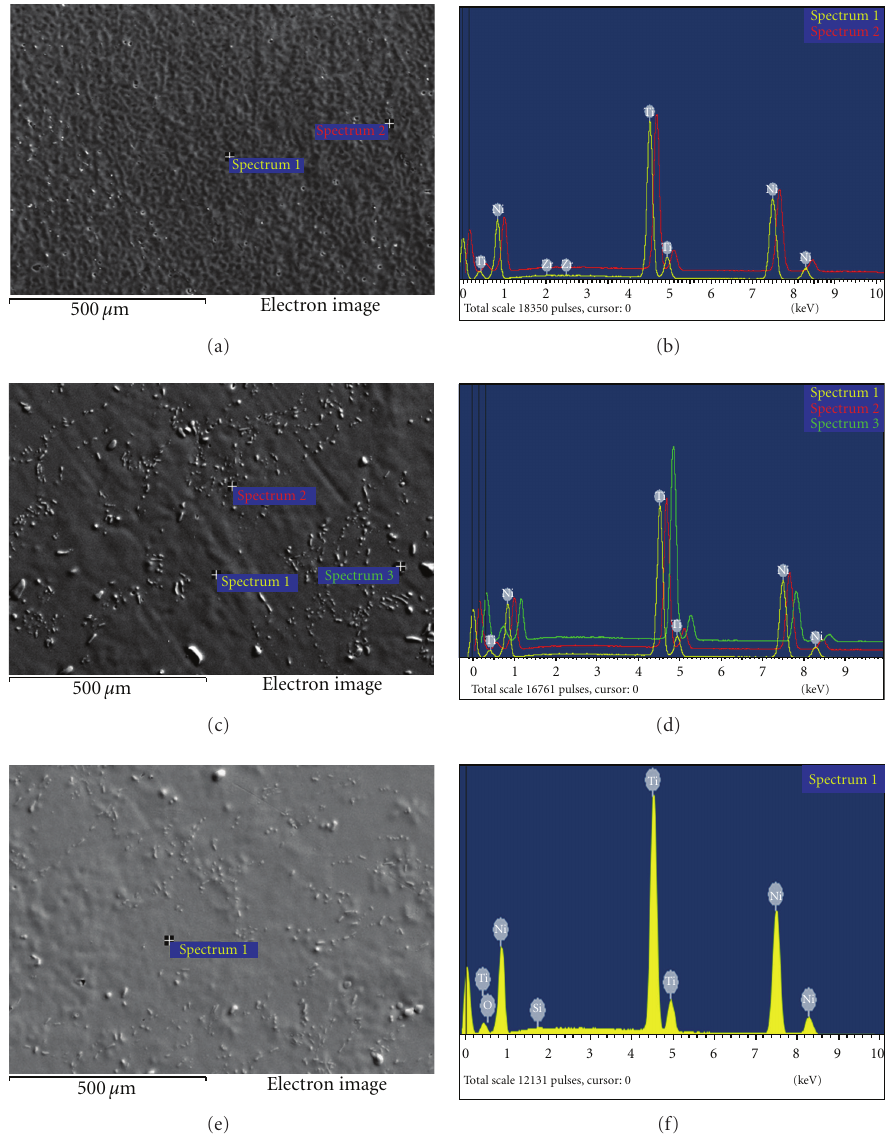
Figure 3: SEM images of the surface and X-ray spectra for the ion-implanted NiTi specimens: (a), (b): Zr ions (NiTi-BG), (c), (d): Ti ions (NiTi-BH), and (e), (f): Si ions (NiTi-BJ).